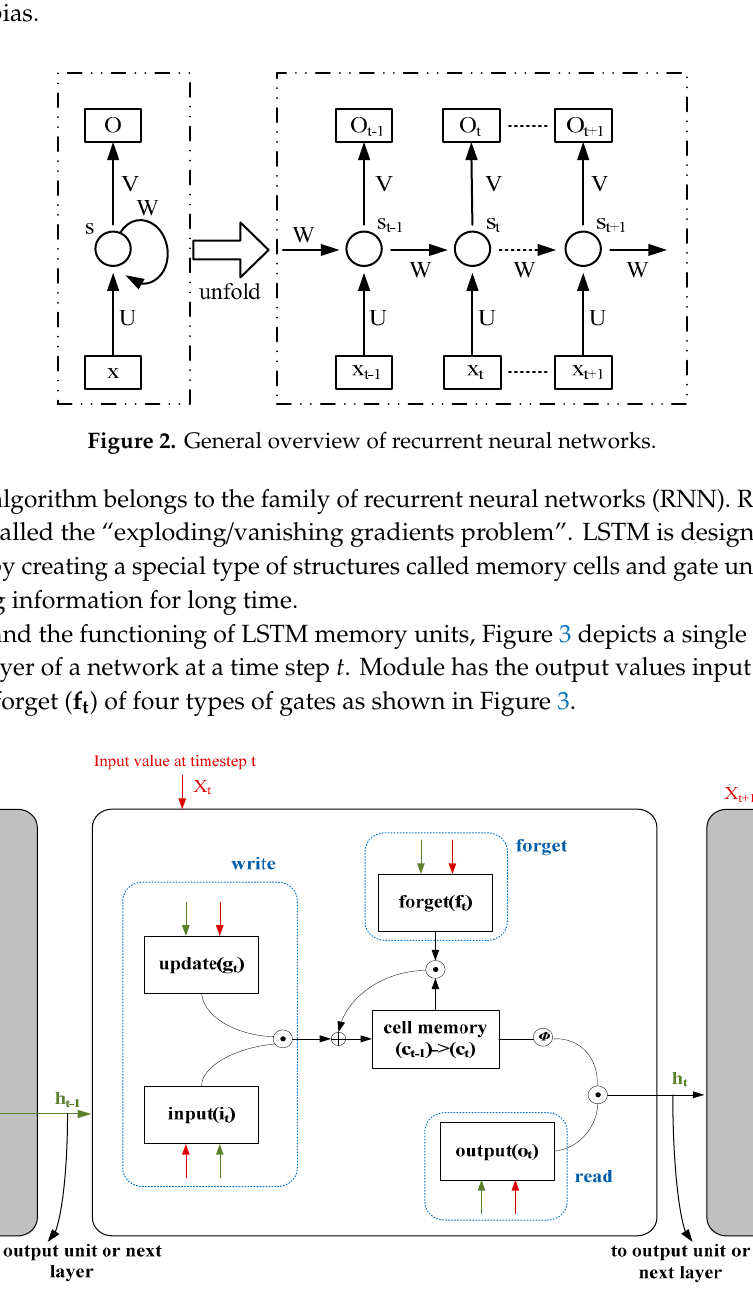
Figure 3. A LSTM (long short-term memory) unit in the first layer for time step Figure 3 . A LSTM (long short-term memory) unit in the first layer for time step (t).